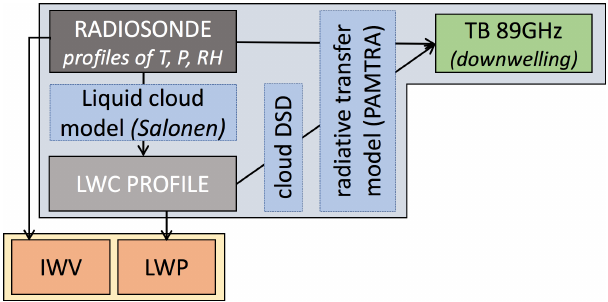
Figure 1. Illustration of the different steps of the forward